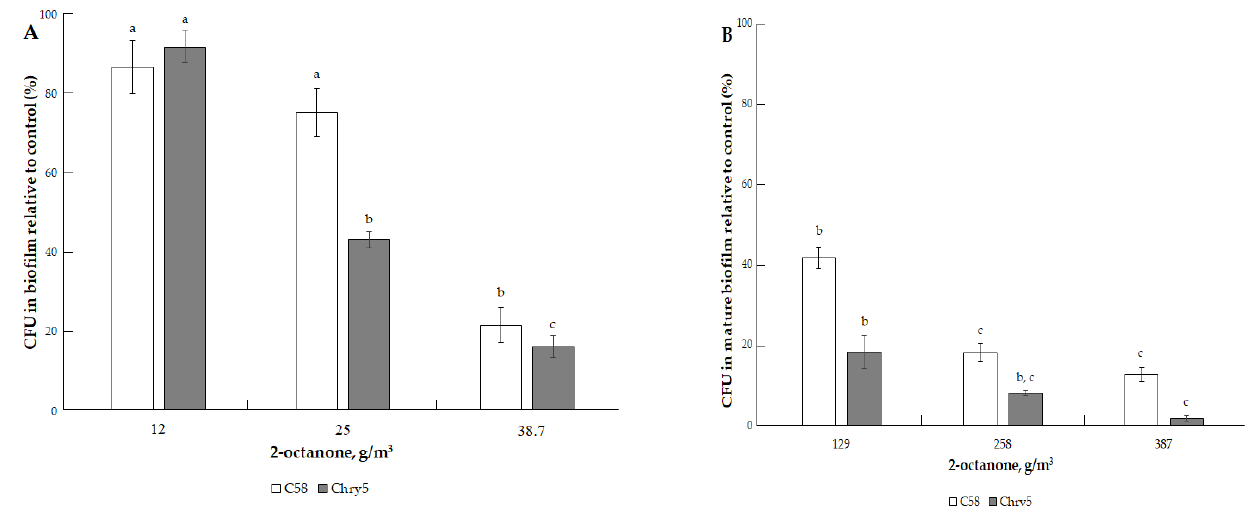
Figure 2. The effect of 2-octanone on the formation of biofilm of A. tumefaciens C58 (white column) and Chry5 (gray column) ( A ) and cell survival in mature biofilms ( B ) depending on the concentration of 2-octanone. CFU of bacteria strains in the control (without VOC): 100 a %. The different lowercase letters above the mean values indicate significant differences ( p ≤ 0.05; Tukey’s HSD test).